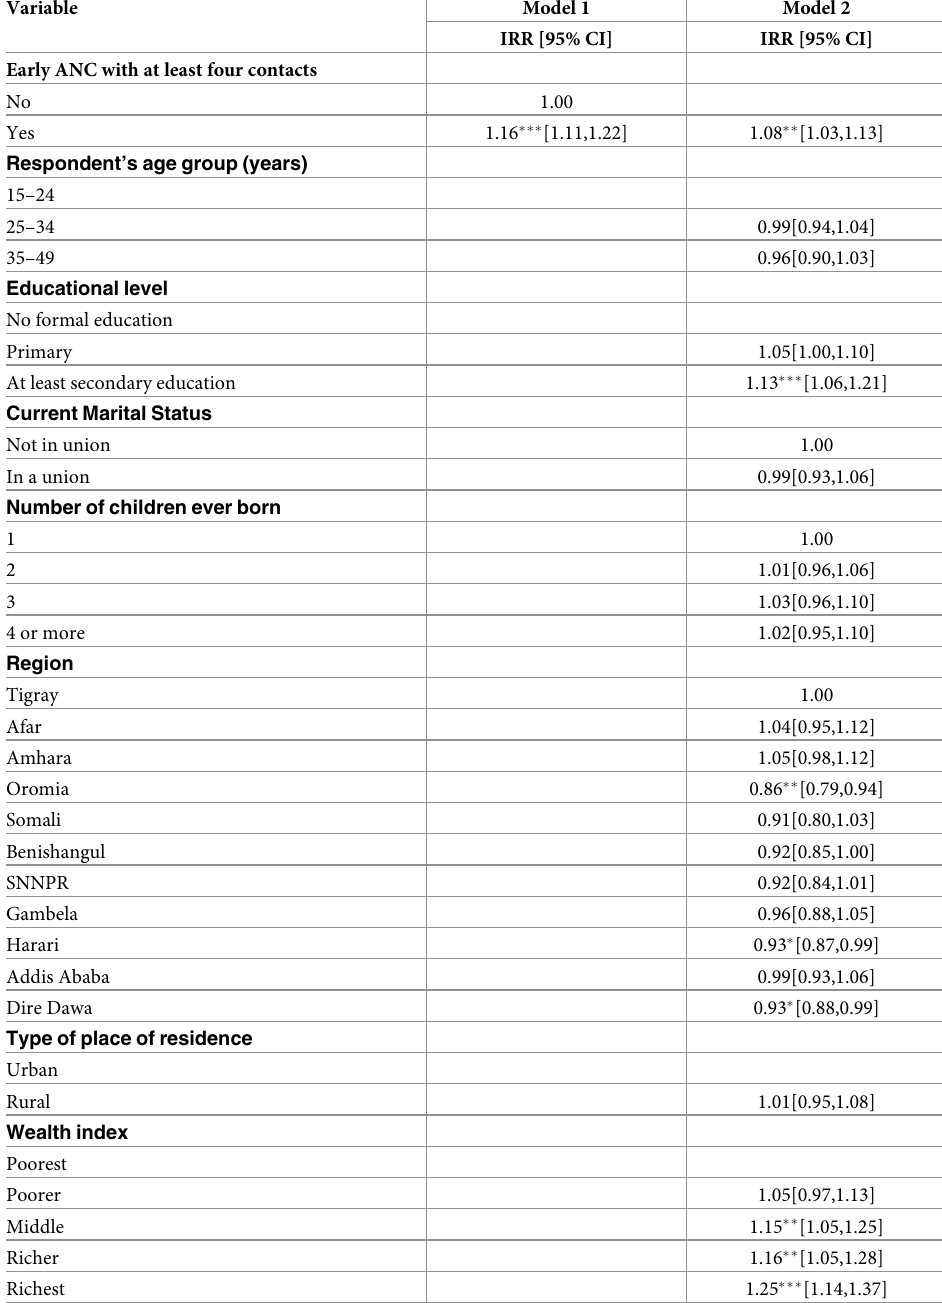
Table 3. Association between early antenatal care with at least four contacts and the number of prenatal care com- ponents received before delivery (N =